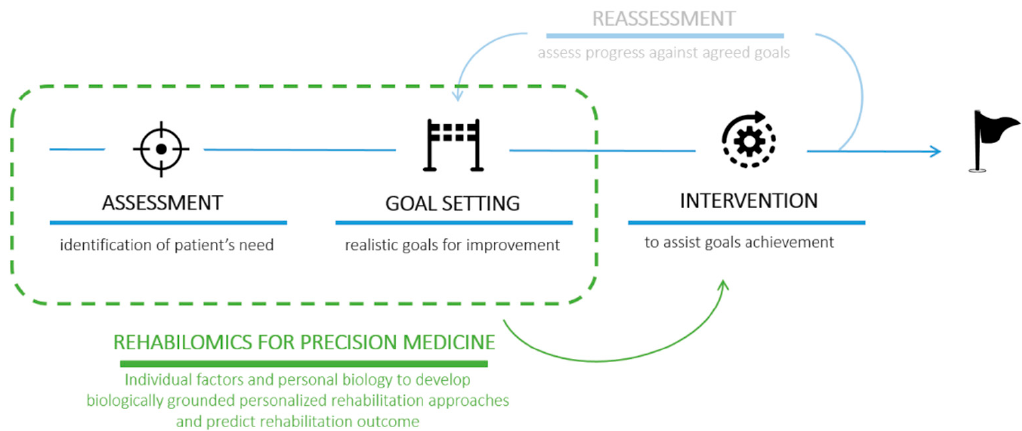
Figure 2. Schematic representation of the 4 phases of the rehabilitation process involving ( 1 ) assessment, ( 2 ) goal setting, ( 3 ) intervention, and ( 4 ) reassessment [17]. The introduction of the rehabilomics approach could accelerate the identification of a personalized intervention (precision medicine) in order to overcome the “reassessment” step (shaded).